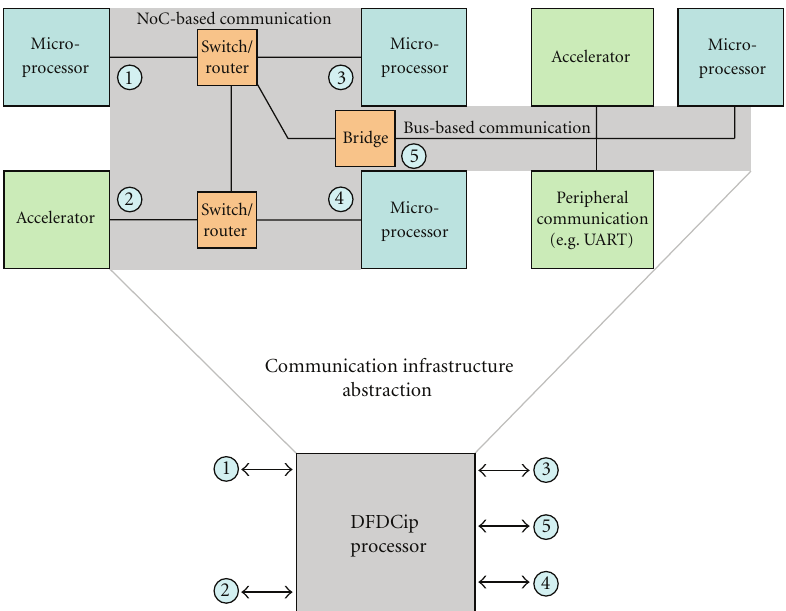
Figure 7: Communication infrastructure abstraction into a data flow dependent communication infrastructure processor